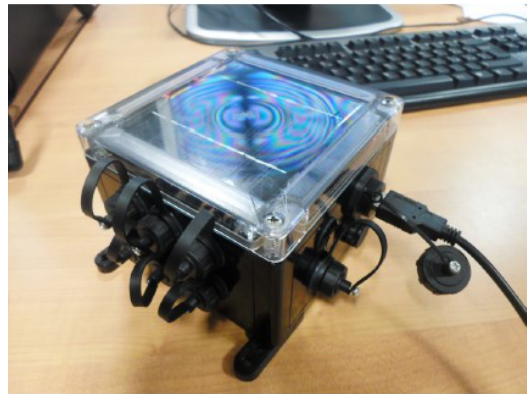
Figure 1. The Waspmote with the embedded accelerometer used in the